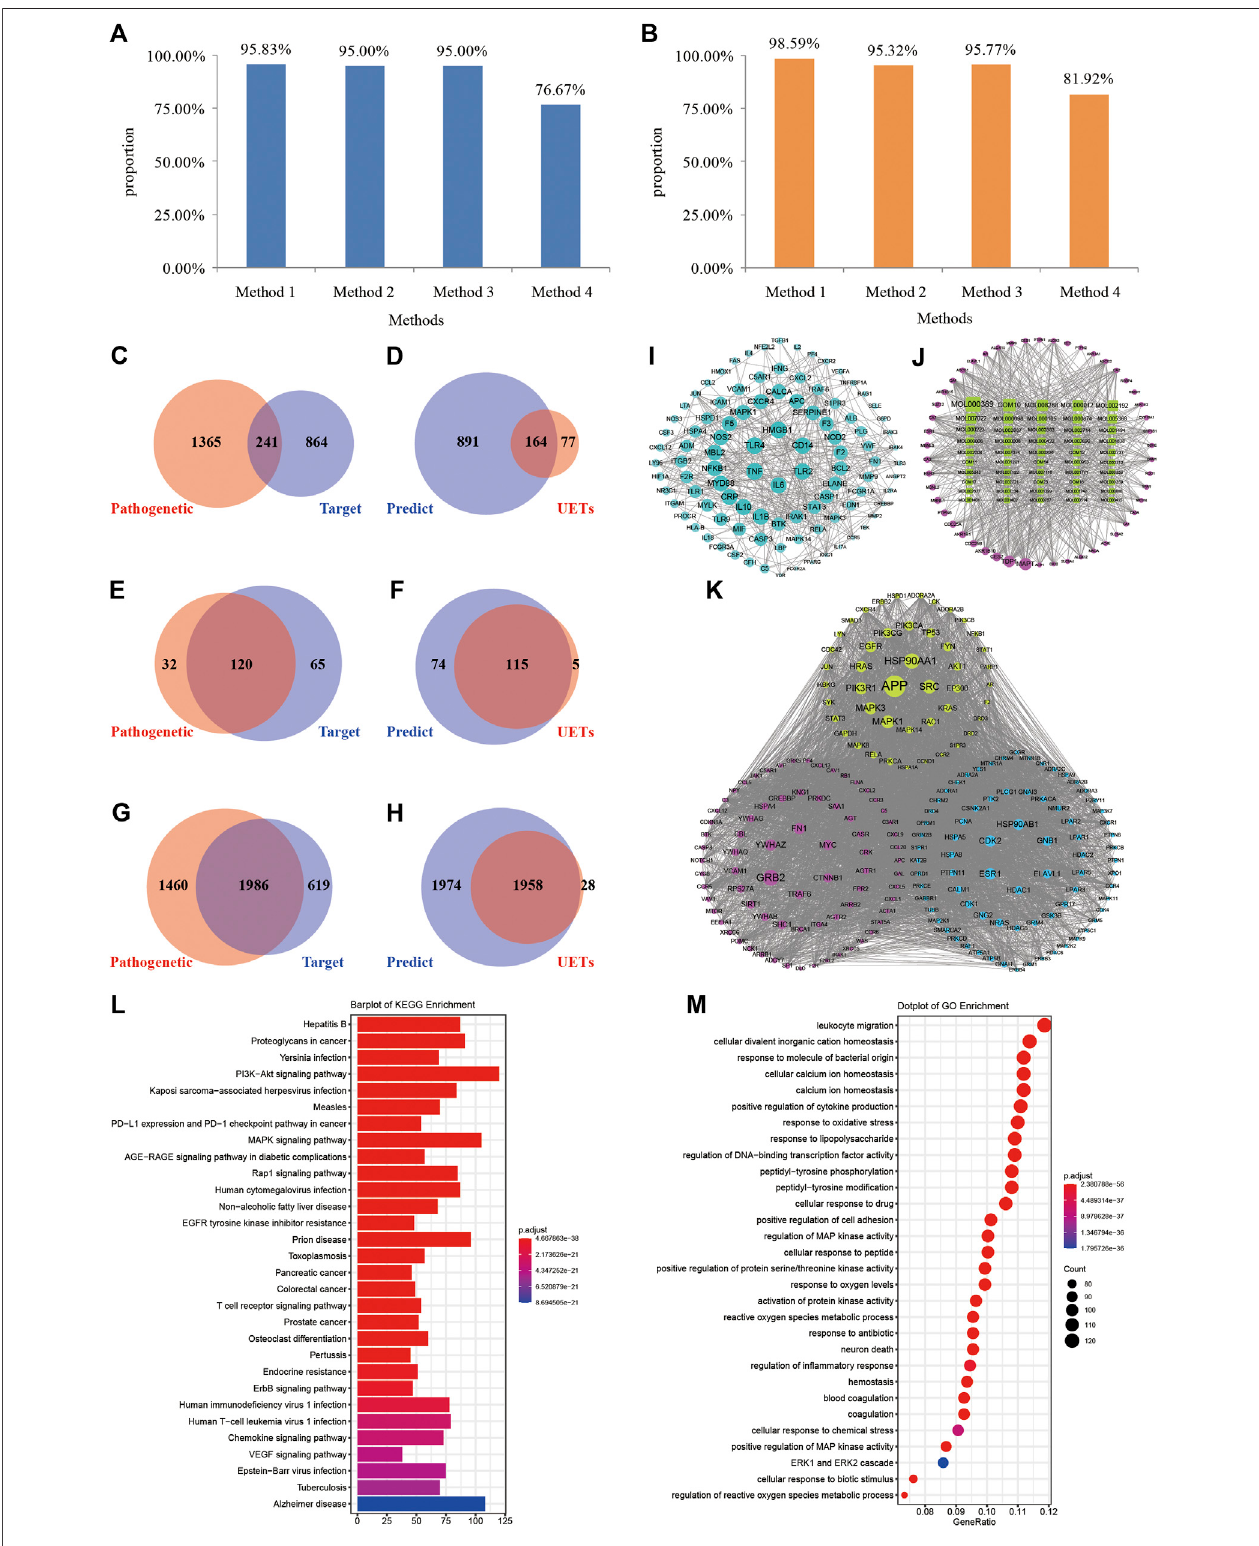
FIGURE6| ConstructionandvalidationofFRS. (A – B) Method1,method2,method3,andmethod4representthenovelnodeimportancecalculationmethodswe proposed, Degree, Closeness Centrality, and Clustering Coef fi cient, respectively. (C) The number of pathogenetic genes and targets; (D) The number of the genes in